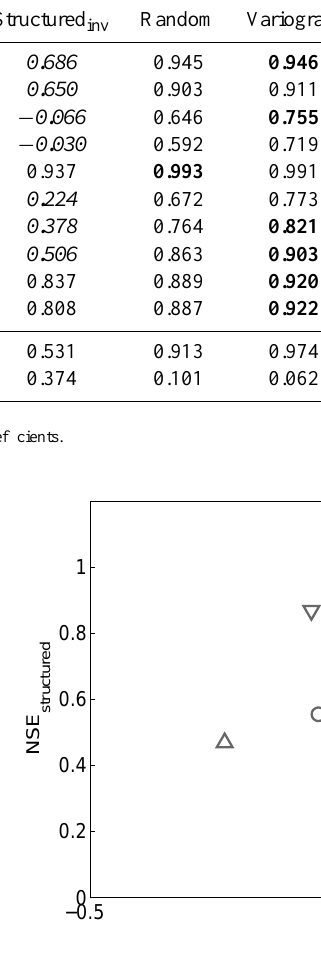
Fig. 9. Nash-Sutcliffe efficiency coefficients of the Structured sce- nario with respect to the Reference scenario (NSE structured ) as a function of the correlation between measured soil moisture and the TWI ( r TWI ,θ